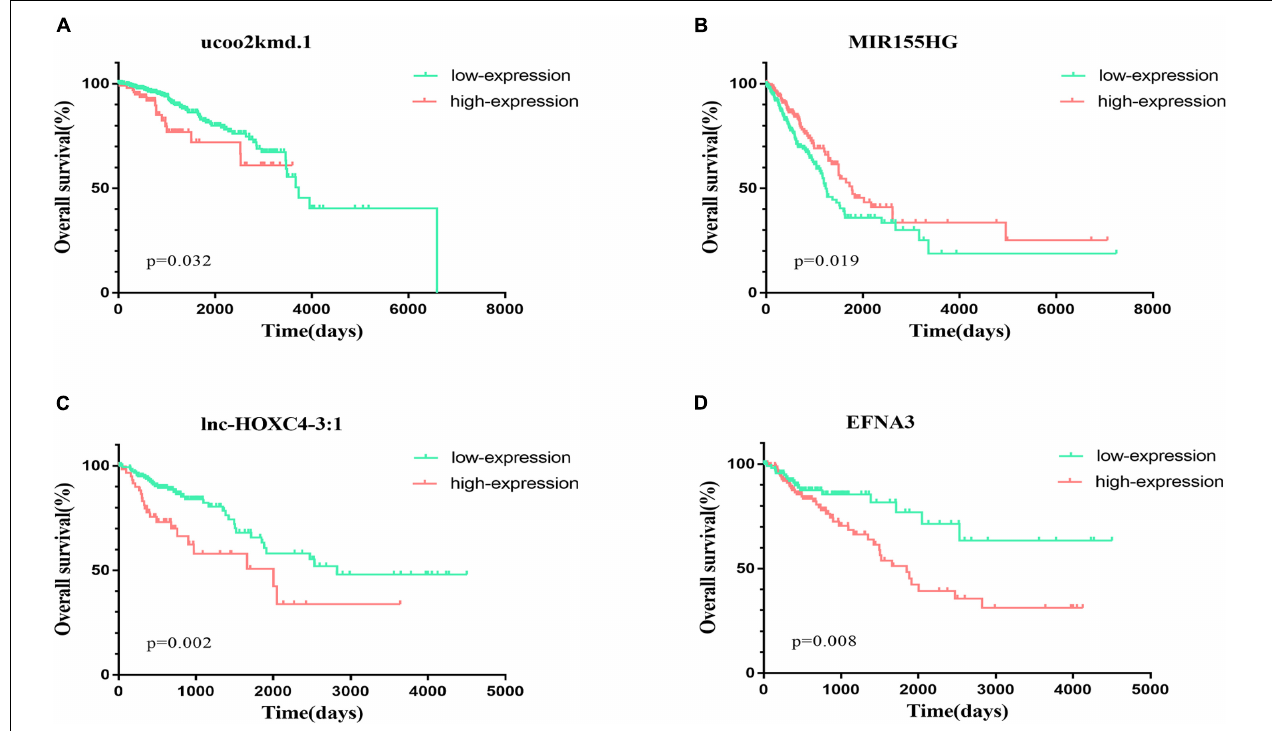
FIGURE 4 | The survival curves of two groups of patients who highly and lowly expressed ucoo2kmd.1 , MIR155HG , lnc-HOXC4-3:1 , and EFNA3 , respectively. The patients were divided into two groups using the surv_cutpoint function of the survminer R package according to the gene expression levels, which were represented as “High-expression” and “Low-expression,” respectively. The red lines denote the relationship between survival time and overall survival for the patients in the “High-expression” group, and the blue lines represent the relationship between the survival time and the overall survival for the patients in the “Low-expression” group. (A) The survival curves of two groups of the breast cancer patients who highly and lowly expressed ucoo2kmd.1 gene, respectively; (B) The survival curves of two groups of the lung cancer patients who highly and lowly expressed MIR155HG gene, respectively; (C) The survival curves of two groups of the colorectal cancer patients who highly and lowly expressed lnc-HOXC4-3:1 gene, respectively. (D) The survival curves of two groups of the colorectal cancer patients who highly and lowly expressed EFNA3 gene,